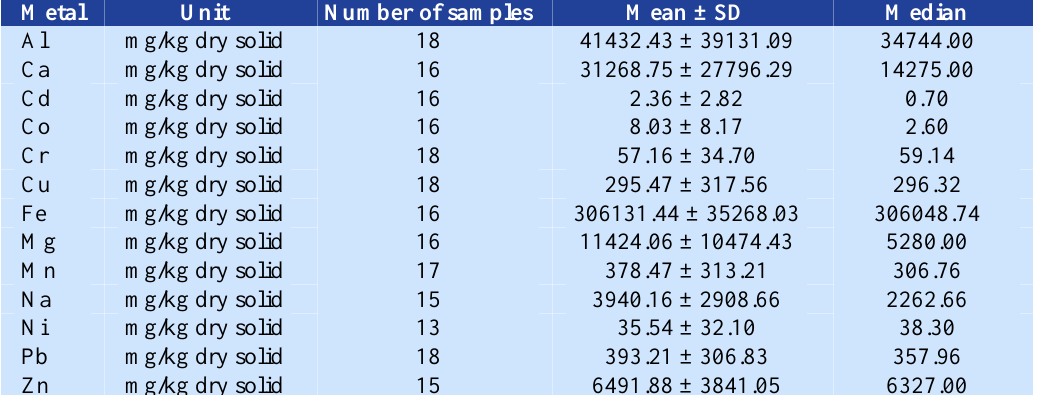
Table 2. Metal content of the cake